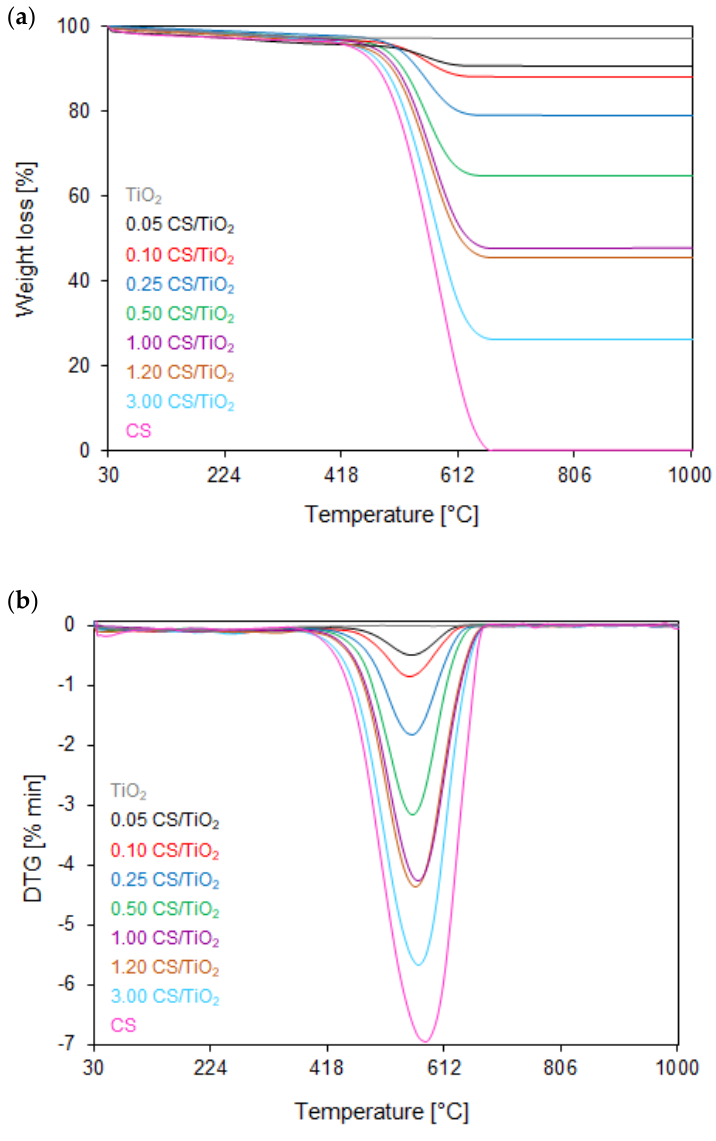
Figure 2. ( a ) TG and ( b ) DTG curves of reference TiO 2 , unmodified CS, and TiO 2 -modified nanocomposites with different carbon sphere contents measured in an oxidizing atmosphere.